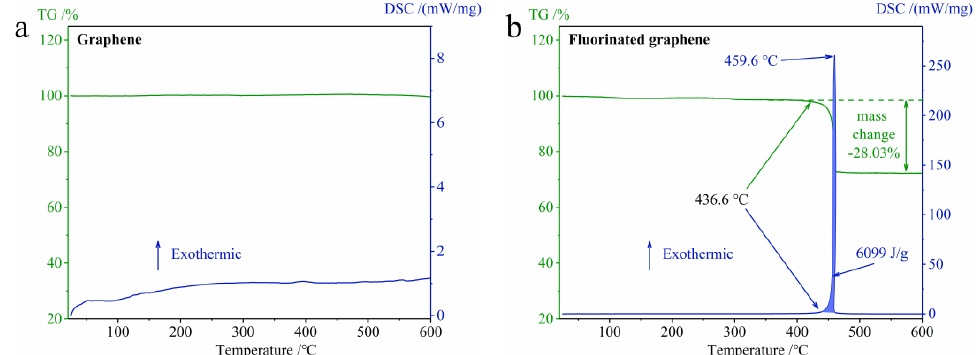
Figure 6. TG-DSC curves of graphene and fluorinated graphene under N 2 at 25–600 ◦ C. ( a ) TG-DSC curves of graphene. ( b ) TG-DSC curves of fluorinated graphene.